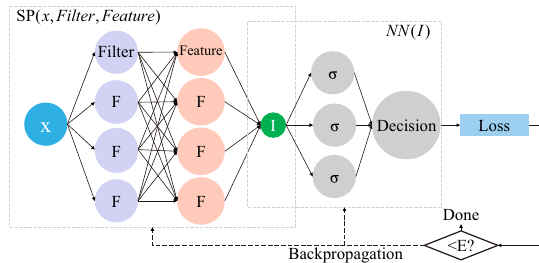
Figure 1 SPINN (Filterbank and feature stages are designed from SP-based methods but realized by DL-based methods. They can extract the information we need (green circle). Then the extracted information is input into a normal neural network (NN) as the final decision stage. The overall SPINN is trained by backpropagation with the target loss until desired training epoch